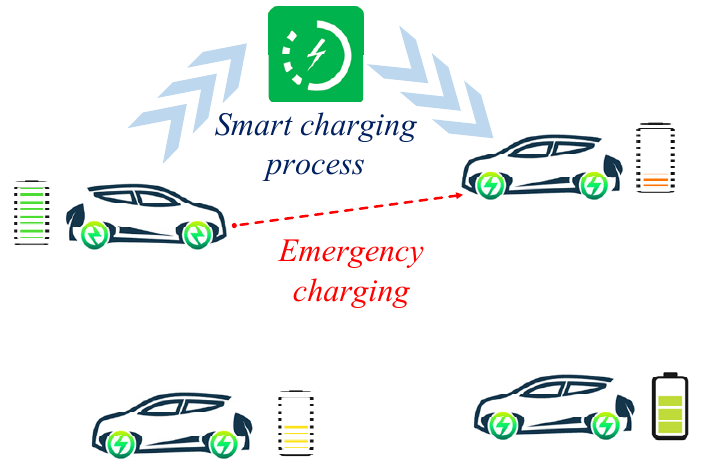
Figure 1. Concept of the EV-to-EV Portable Battery Charger.